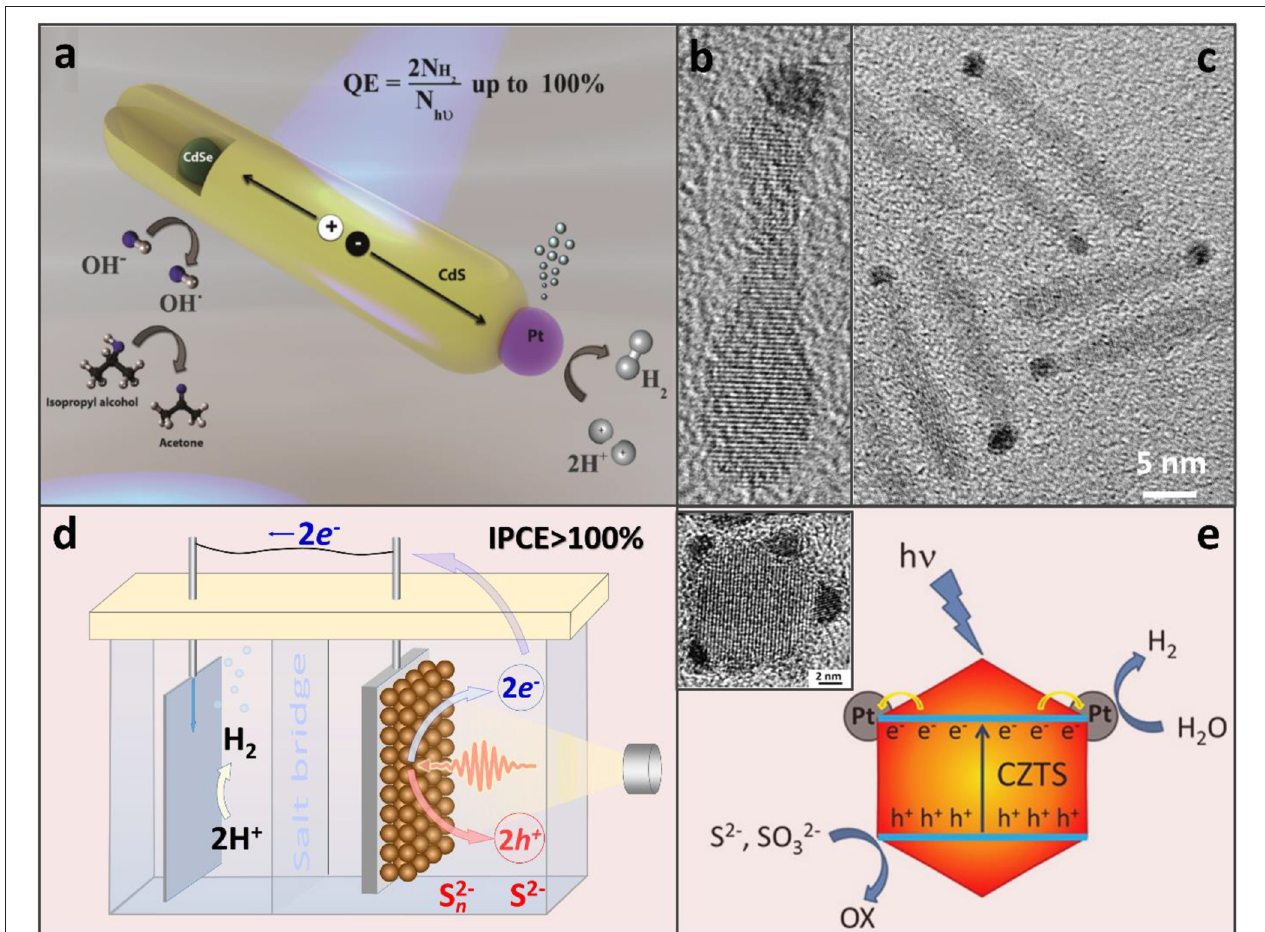
FIGURE 1 | (a) CdSe/CdS nanorods appended with a Pt co-catalyst that serves the role of an electron sink for the accumulation of photoinduced electrons at a single reductive site. Adapted with permission from Kalisman et al. (2016). Copyright 2016 American Chemical Society. (b,c) TEM images of CdSe/CdS nanorods selectively tipped with a Pt catalyst on one side. Based on the location of the CdSe bulb, Pt appears to grow on an opposite end. Adapted with permission from Khon et al. (2013). Copyright 2016 American Chemical Society. (d) Photoelectrochemical hydrogen evolution from aqueous Na 2 S solution with over 100% of incident photon-to-current efficiency (IPCE). PbS NC-based active region of the working electrode (right, brown spheres) where one photon may be converted into two electron-hole pairs via MEG (Yang et al., 2014). Energized electrons are then transferred to the dark electrode (left) for H 2 production and sulfide ions are oxidized by the holes. (d) Illustration of the H 2 evolution on CZTS-Pt heterostructured nanoparticles in the presence of S 2 − and SO 2 − 3 hole scavengers. Adapted with permission from Yu et al.